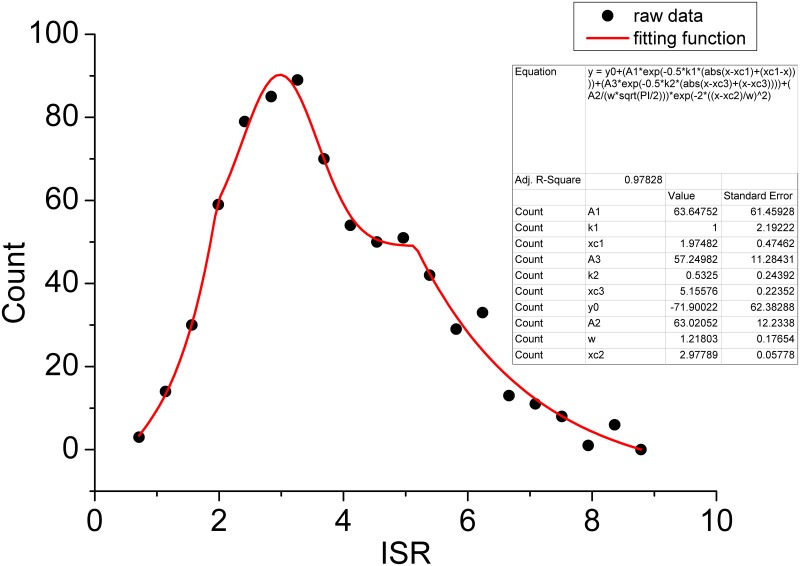
The distribution of the specificity(ISR) with 720 compounds binding to the Cox2.the vertical axis represents the number of states or probability for the specificity, gaussian curve: in the center; exponential curve: near the tail. The parameter values for these distributions are presented. The analytical function consisting of a Gaussian and two exponential functions is highlighted with red line.